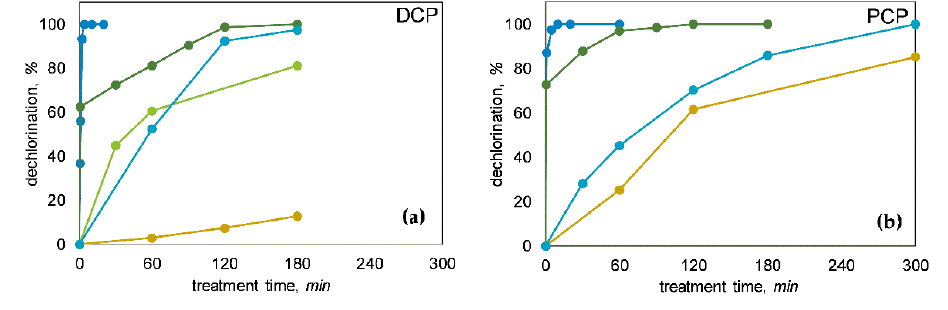
Figure 3. Dechlorination (i.e., conversion of organic chlorine into chloride; see Equation (3) in Section 2.4) of ( a ) 2,4-dichlorophenol (DCP) and ( b ) pentachlorophenol (PCP) during ozonation (OZ), photocatalysis (PC), photooxidation (PO), and sequential method (SQ).